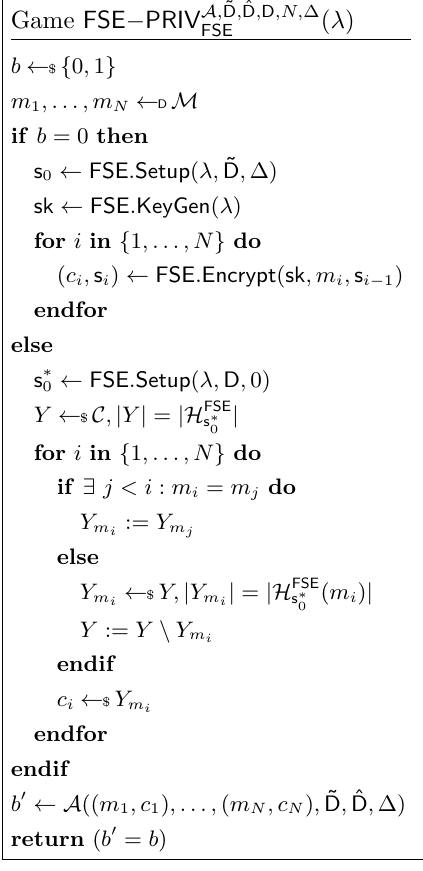
Figure 2: The privacy game for an FSE